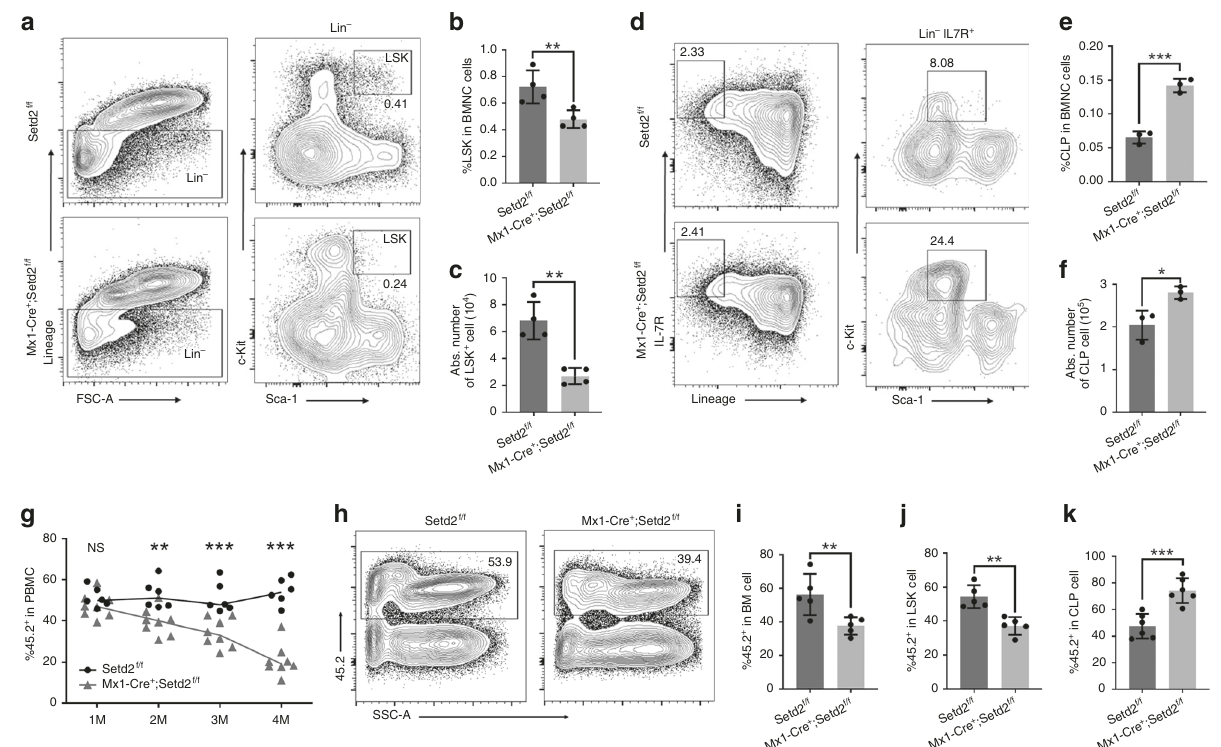
Fig. 2 Setd2 knockout leads to decreased HSC numbers and repopulating capacity and to skewed lymphoid differentiation. a – c The fl ow cytometry pro fi les of LSK (Lineage − Sca-1 + C-kit + ) cells in bone marrow from Setd2 knockout and control mice show a decrease in the frequency ( b ) and total number ( c ) of HSC-enriched LSK cells ( n = 8). d – f Representative fl ow cytometry plots of common lymphoid progenitors in bone marrow from Setd2 knockout and control mice ( d ); the frequency and absolute number of CLPs are shown in ( e ) and ( f ). (CLP: Lineage − IL-7R + c-kit + Sca-1 mid ; n = 6). g Peripheral blood chimerism was examined monthly after pIpC treatment of recipient mice ( n = 14). h – k Flow cytometric analysis of the frequency of CD45.2-derived BMNCs ( h , i ), LSK cells ( j ), and CLPs ( k ) in recipients at 4 months after pIpC induction ( n = 10). (The data are presented as the means ± SDs. * p <